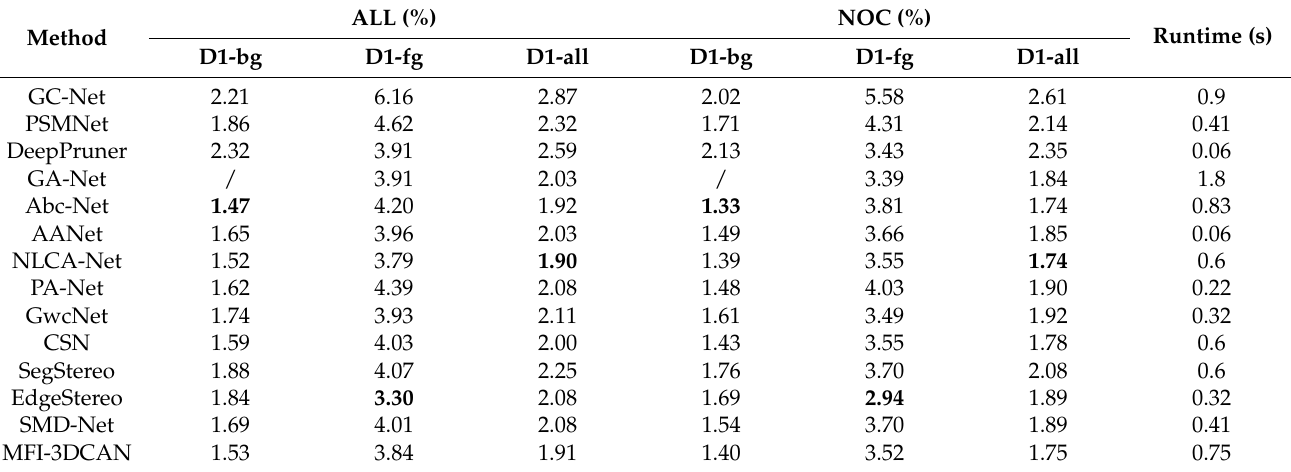
Table 4. Results of our method and top-performance models on the KITTI 2015 leaderboard.